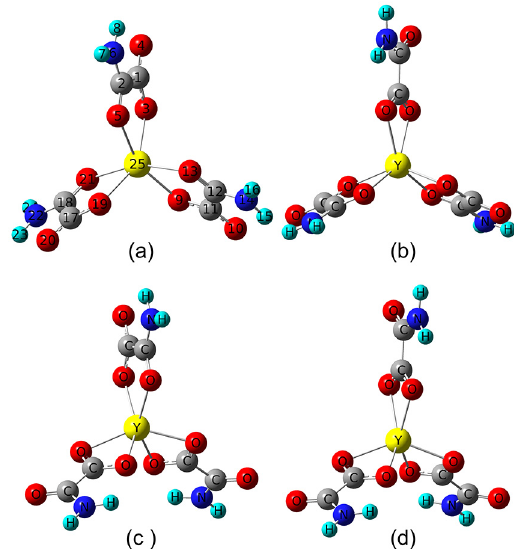
Figure 3. Optimized geometric structure of the Y(L)3: (a) Isomer 1 (more stable), (b) isomer 2, (c) isomer 3 and (d) isomer 4.